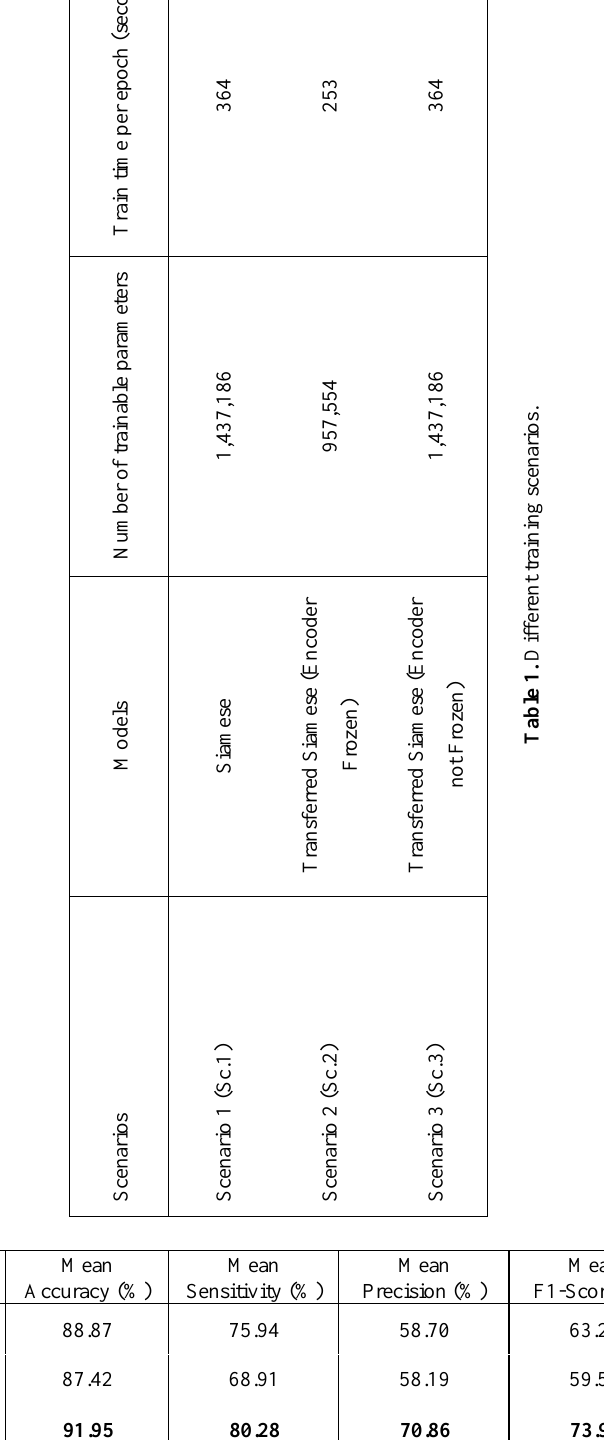
Table 2. Quantitative results of the testing scenarios (max values are